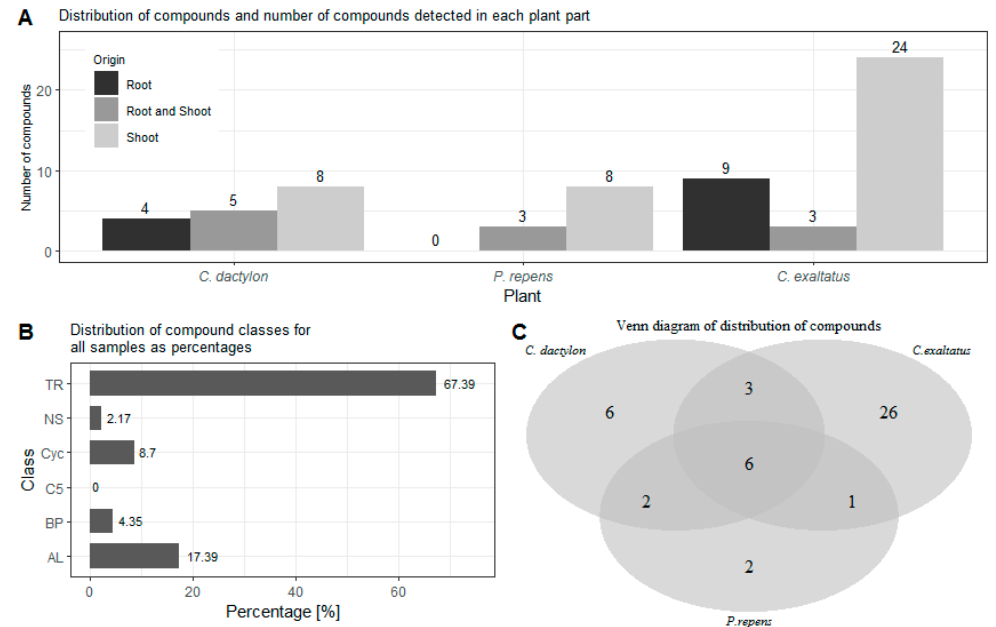
Figure 1. ( A )—Shows the distribution of compounds detected in the roots, shoots, and both plant parts for each of the graminoid plants. ( B )—Shows the percentage distribution of the classes for the identified compounds for all samples analyzed. ( C )—Shows a Venn diagram of the number of unique compounds detected for each of the three plants as well as the number of compounds found in two or all three plant species. TR—Terpenoid, AL—Aliphatics, BP -Benzenoid/Phenylpro- panoids, C5- C5-branched compounds, NS—Nitrogen- or sulfur-containing compounds, Cyc—Cy- clic miscellaneous